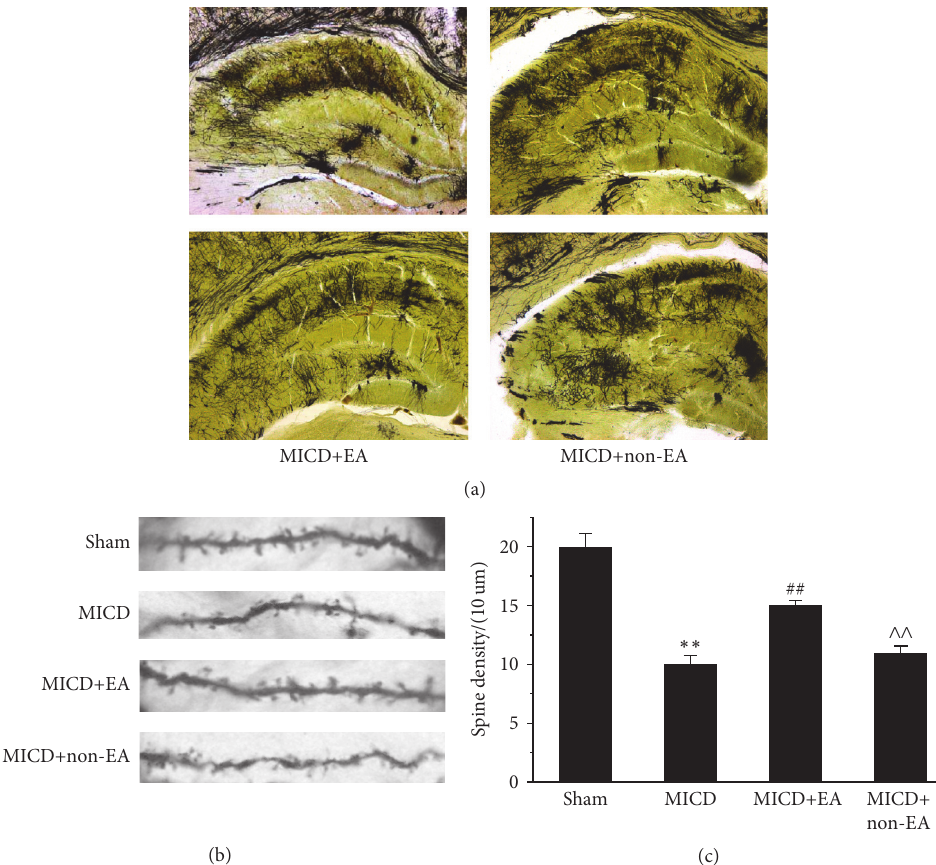
Figure 4: The structures and densities of dendritic spine in the hippocampus of rats. (a) Representative images of dendritic spine in the hippocampus of each group (Golgi staining, × 50). (b) Representative images of dendritic spine density and morphology from the pyramidal cell layer of hippocampal CA1 area in each group (Golgi staining, × 1000). (c) The density of dendritic spine was analyzed in hippocampal CA1 pyramidal cells in each group ( 𝑛 = 6 /group; ∗∗ 𝑝 < 0.01 versus the Sham group; ## 𝑝 < 0.01 , # 𝑝 < 0.05 versus the MICD group; ∧∧ 𝑝 < 0.01 , ∧ 𝑝 < 0.05 versus the MICD+EA group). All experiments were repeated three